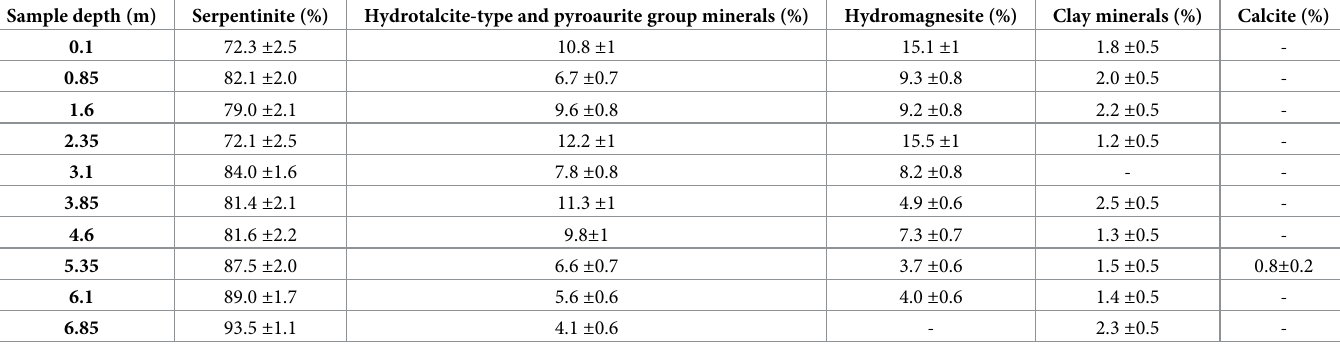
Table 1. Sample X-Ray diffraction mineral identification and percent composition in the serpentine rock core taken at the Khalilovsky massif a . Sample depth